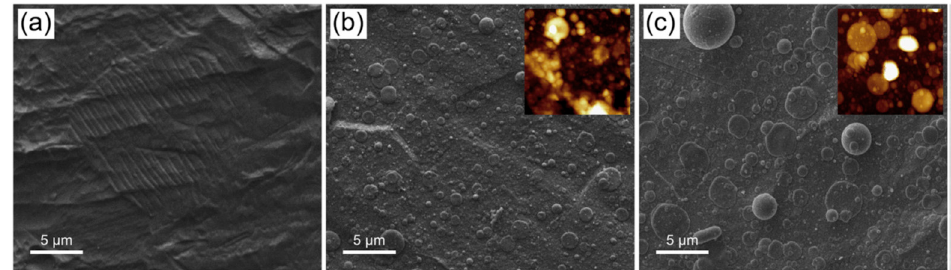
Figure 4. Effect of laser fluence on BG film growth: ( a ) Ti surface, BG deposited on Ti at ( b ) 50 mJ and ( c ) 100 mJ. Reproduced with permission from [108], copyright from 2019 Elsevier.